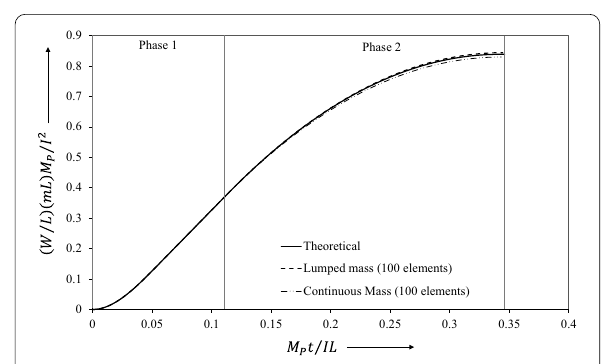
Fig. 13 Central displacement at ξ ∗ ( P 0 = 12.5 P c ) .